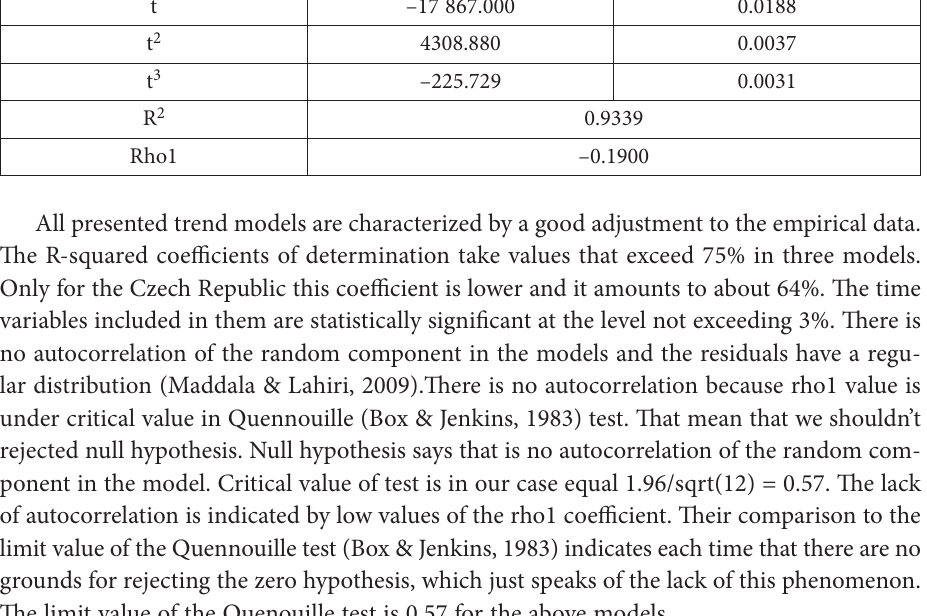
Table 7. The trend model of the bankruptcy in Hungary in the years 2005–2016 (source: Own work) coefficient p value const 26